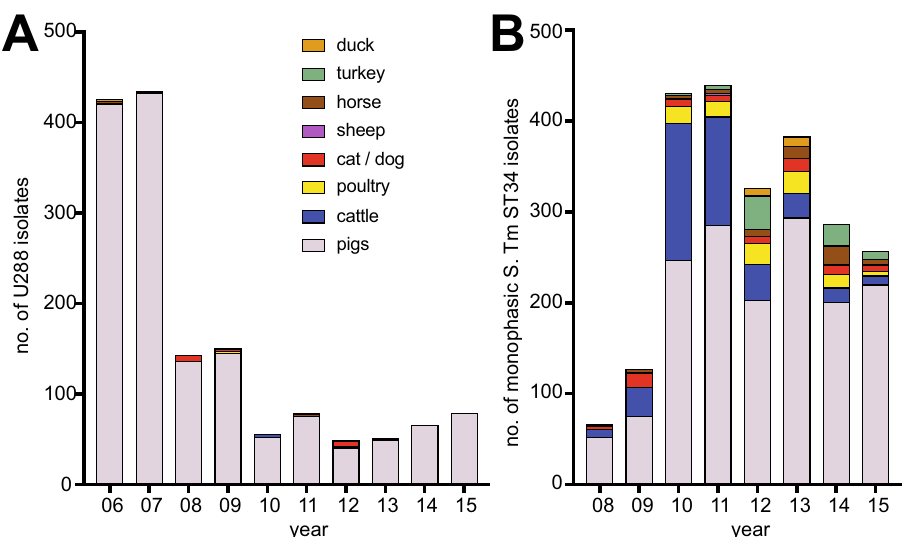
Fig. 1 Animal species source of monophasic S . Typhimurium U288 and S . Typhimurium ST34. Stacked bar chart indicating the animal source (see colour key inset) of S . Typhimurium U288 ( A ) and monophasic S. Typhimurium ST34 ( B ) isolated in England and Wales by Animal and Plant Health